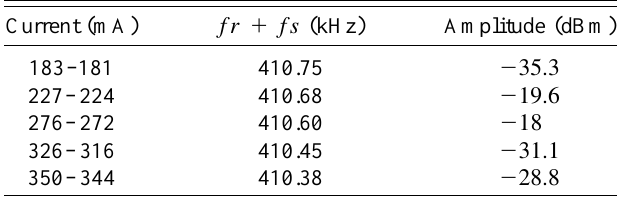
TABLE II. The measured currents, dipole-mode frequency, and intensity for these measurements.